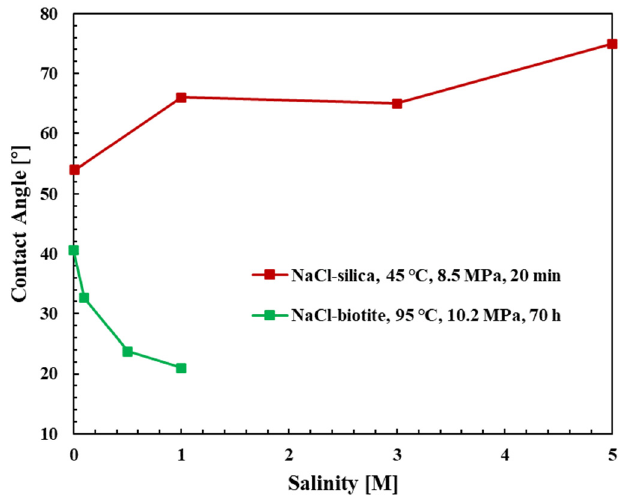
Figure 3. Water contact angle as a function of salinity in the CO 2 -NaCl brine-mineral systems after reaction with CO 2 for different periods [37,41].